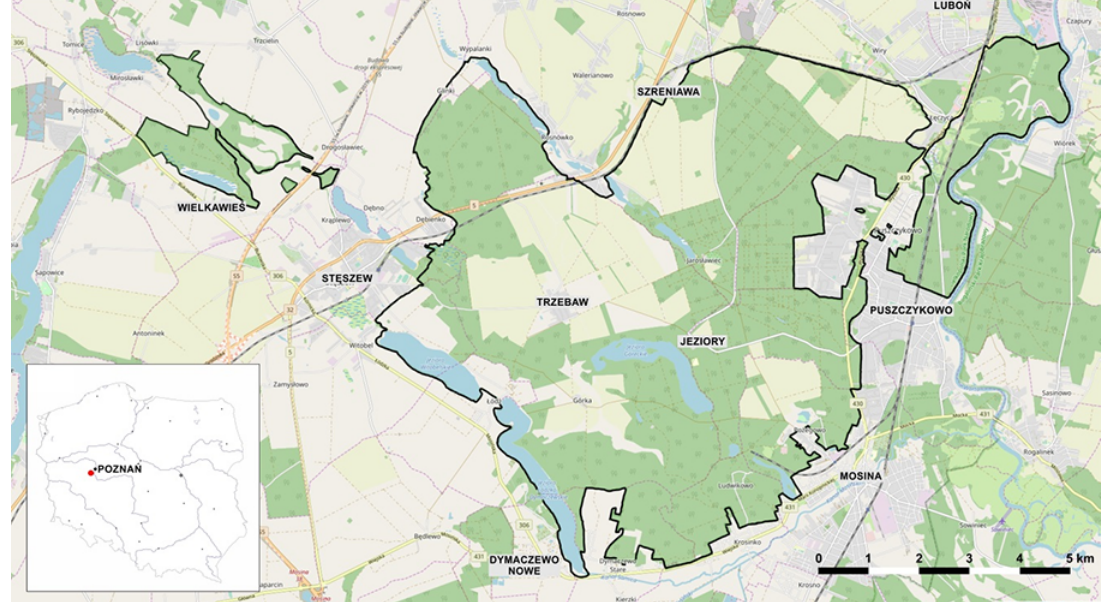
Figure 1 Borders of the Wielkopolska National Park and location of the study area in Poland Based on OpenStreetMap: https://www.openstreetmap.org/